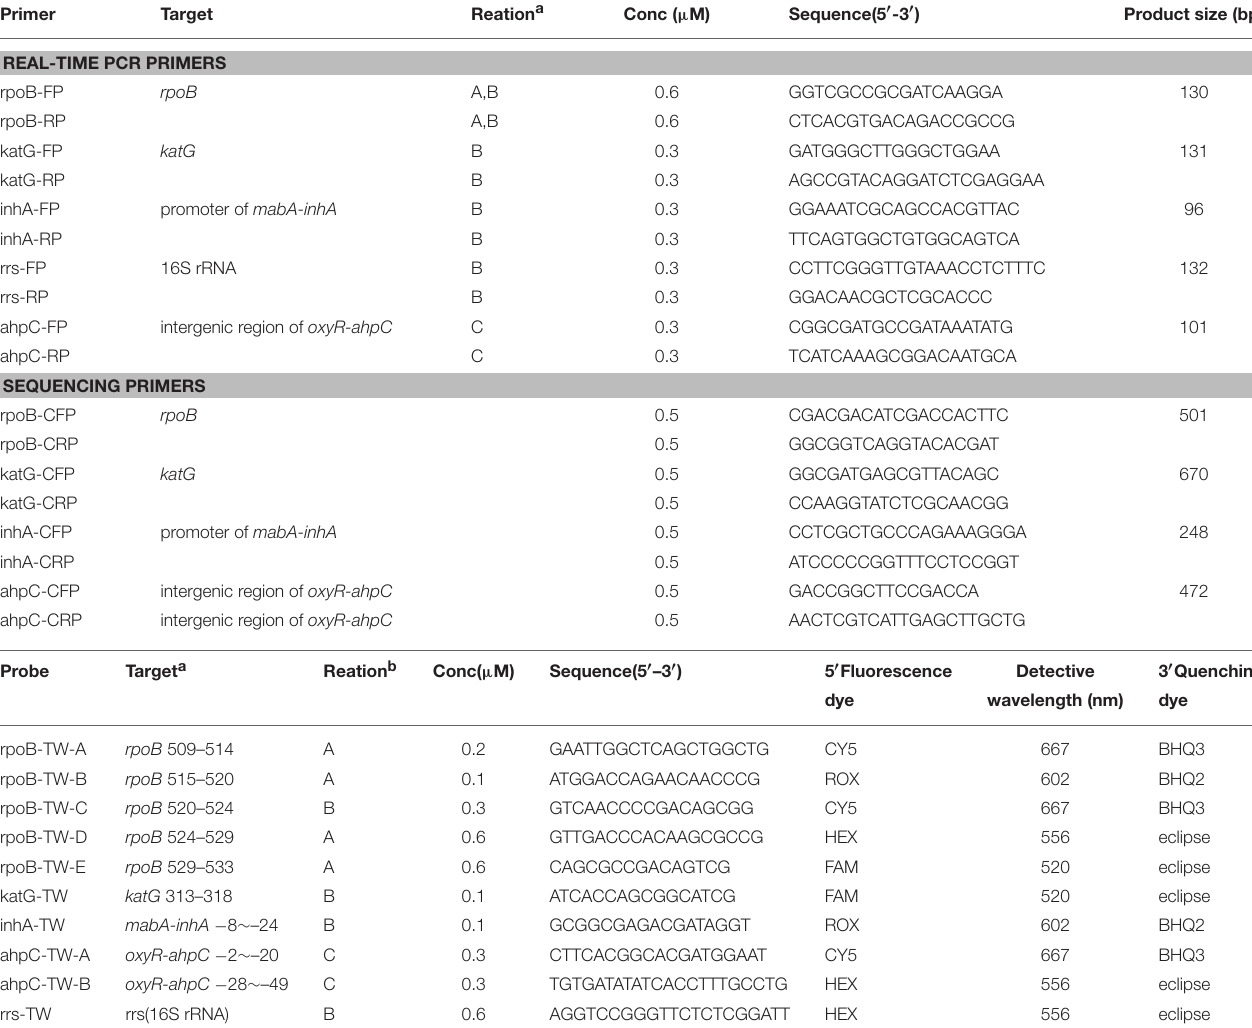
TABLE 1 | Primers and Probes designed and used in this